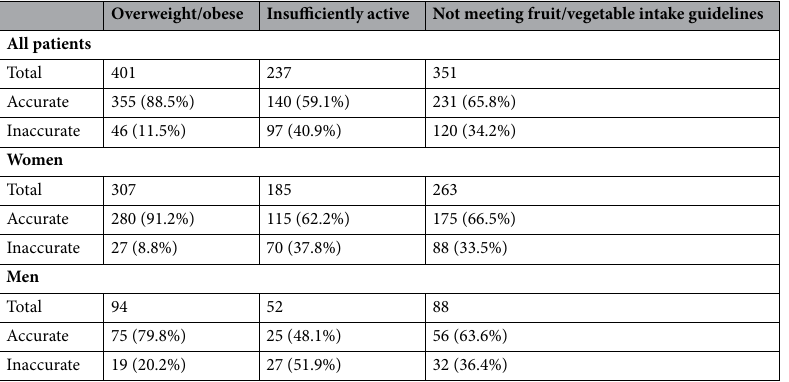
Table 4. Rates of concordance between actual and self-perceived weight status and energy balance behaviors at baseline in high risk patients. High risk patients defined as patients with BMI ≥ 25 kg/m 2 , who were insufficiently active, or did not meet minimum recommended daily fruit/vegetable